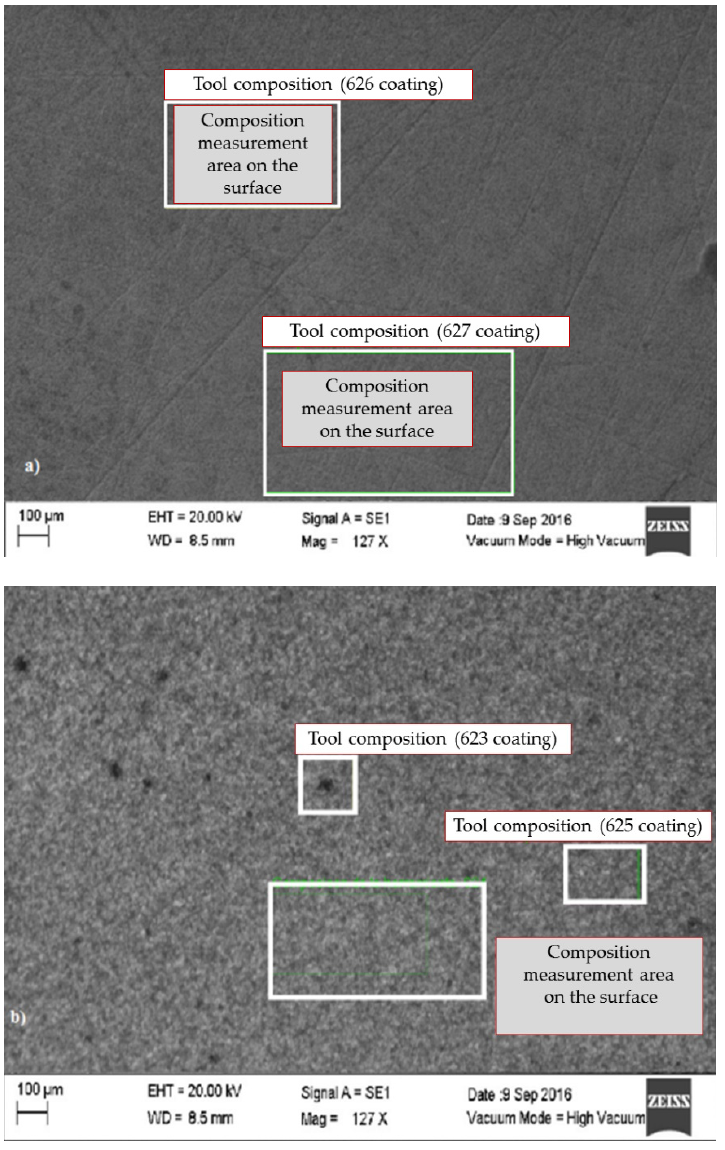
Figure 3. Microstructure of the tool with 127X magnification: ( a ) external zone and ( b ) internal zone. EHT: Electron High Tension. WD: Working Distance. Table 1. Chemical composition of the cutting